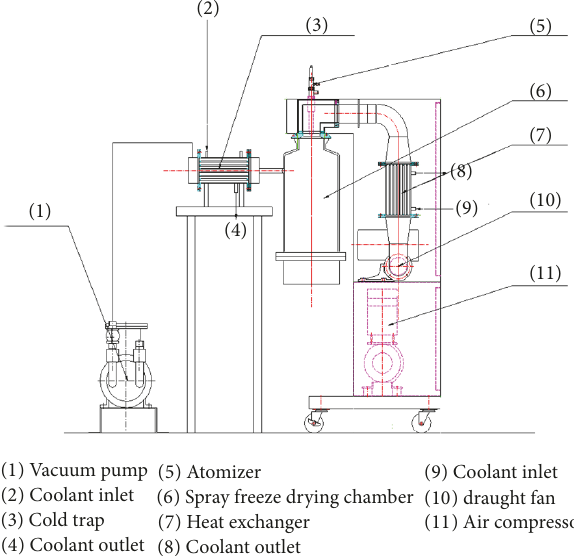
Figure 1: The schematic diagram of vacuum spray freeze